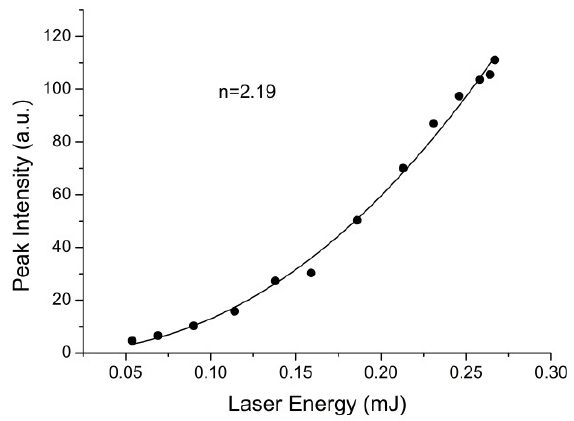
Figure 3. The dependence of the SH intensity on the pump energy for frozen suspension at nanosec- ond pump-pulse duration with fitting